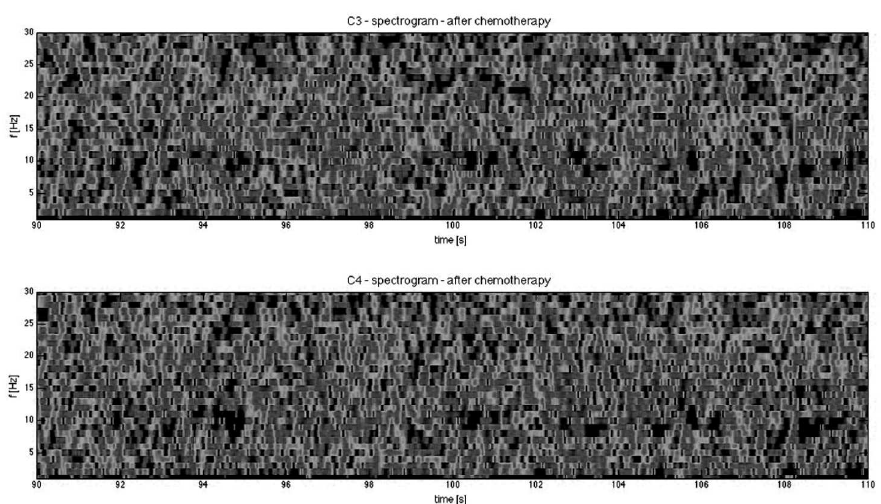
Figure 4. Spectrogram and EEG data from electrodes C3 and C4, 40s recording, eyes closed – after chemotherapy, with various artifacts such as eye blinking and eye movement